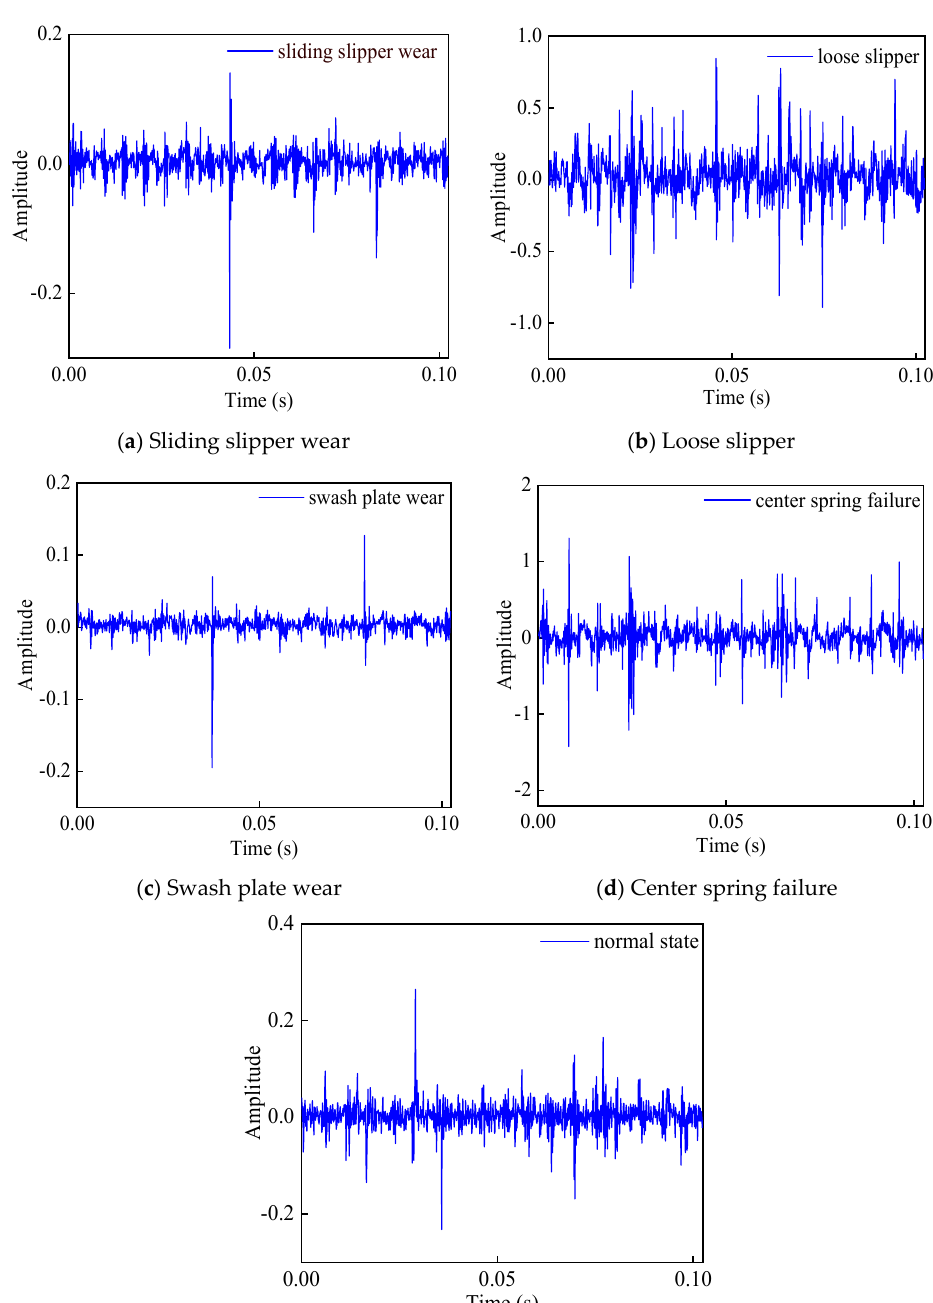
states: normal state, sliding slipper wear, central spring failure, swash plate wear, and loose slipper. Among them, the selected four failure states are the common failure cases of piston pump. The partial time-domain waveforms of vibration signals are shown in Figure 4.